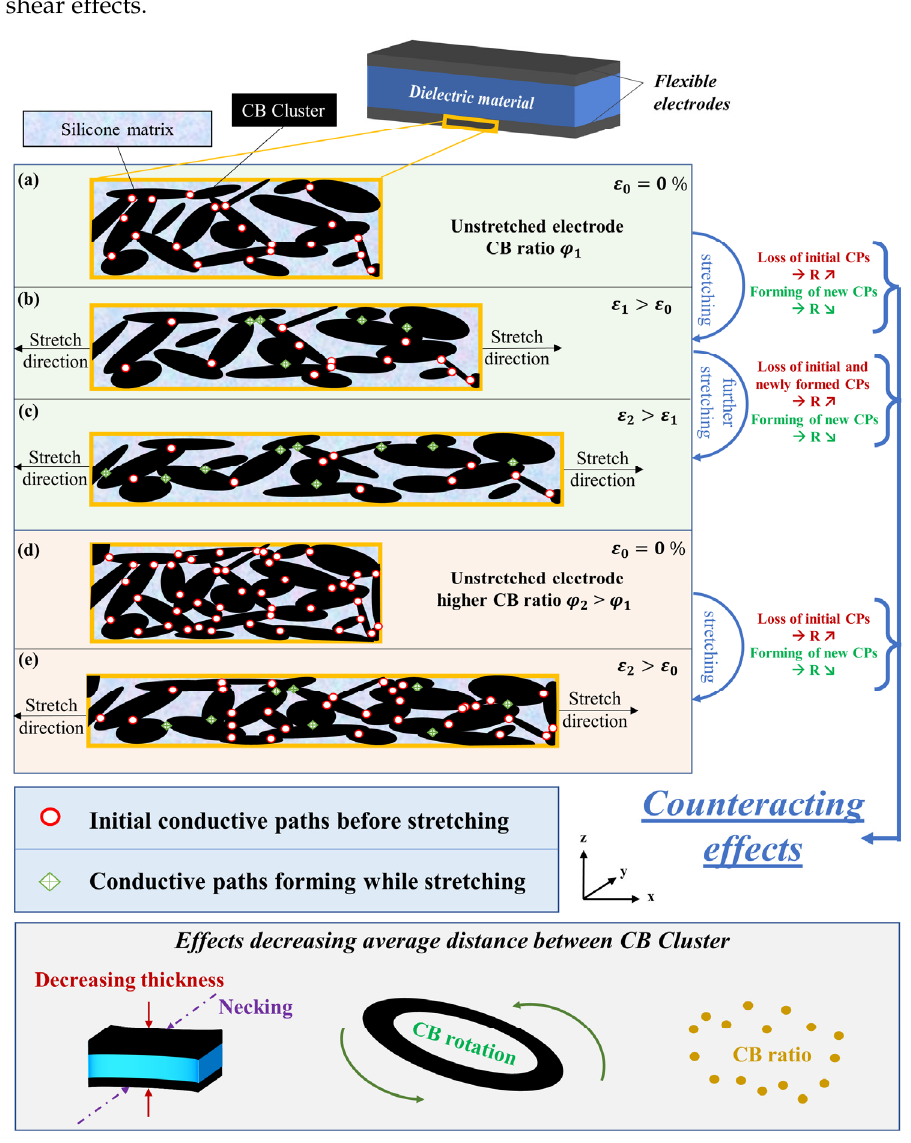
Figure 7. Schematic visualization of the CB behavior and the resulting conductive paths (CPs) while stretching to different strains ε i (i = 0; 1; 2), simplified to a 2-dimensional view inside an electrode with CB as conductive particles and a polymeric matrix of a DE: ( a ) Unstretched electrode with a lower CB ratio φ 1 ; ( b ) Stretched electrode with lower CB load φ 1 ; ( c ) Further stretched electrode with lower CB load φ 1 ; ( d ) Unstretched electrode with higher CB load φ 2 > φ 1 ; ( e ) Stretched electrode with higher CB load φ 2 > φ 1 ; Bottom: Schematic visualization of possible mechanisms, which decrease the average distance between CB clusters while stretching.